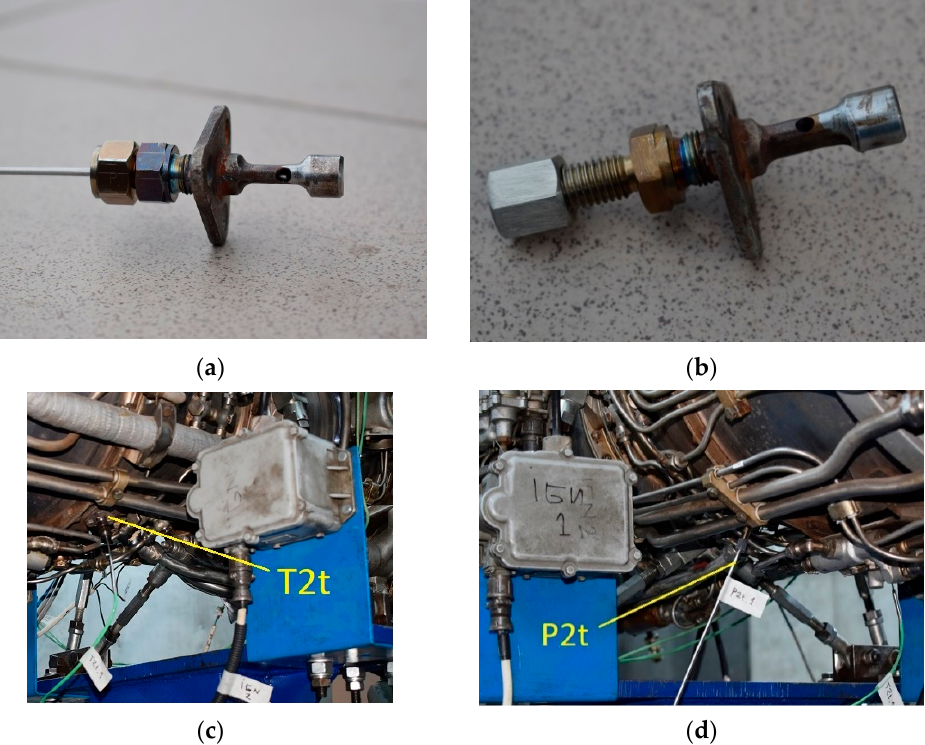
Figure 9. Compressor total outlet temperature probe ( a ); compressor total outlet pressure probe ( b ); compressor total outlet temperature probe location ( c ); compressor total outlet pressure probe location ( d ).